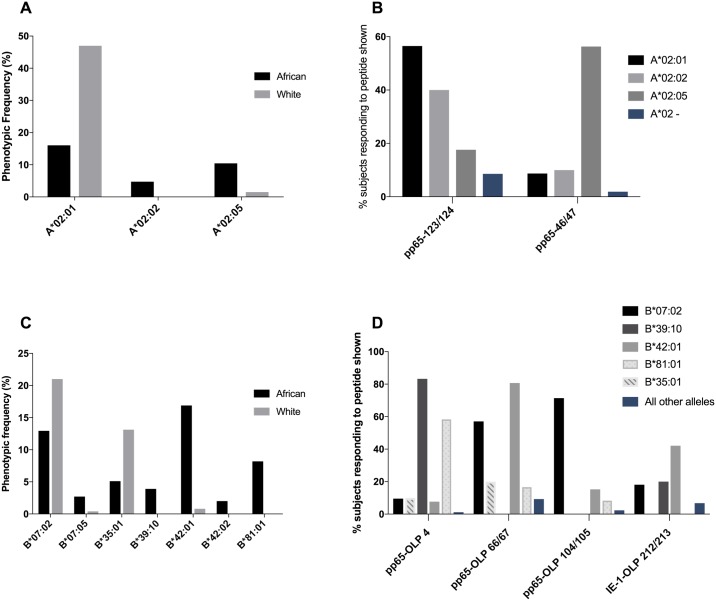
Phenotypic frequencies of closely related HLA I molecules and their impact on CMV specific CD8+ T-cell hierarchies.(A) The phenotypic frequency of some of the HLA class I molecules in A2 superfamily in white populations [28] and our African cohort. (B) The percentage of subjects with HLA alleles A*02:01 (n = 23), A*02:02 (n = 10) and A*02:05 (n = 16), responding to epitope (NLVPMVATV) in pp65-123/124 peptide and predicted epitope (FVFPTKDV) in pp65-46/47 peptide. (C) The phenotypic frequency of the HLA class I molecules in B07 superfamily in white populations [28] and our African cohort. (D) The percentage of subjects with B*07:02 (n = 21), B*35:01 (n = 10), B*39:10 (n = 6), B*42:01 (n = 26) and B*81:01(n = 12) alleles in our African cohort responding to predicted epitopes in pp65, GPISGHVL (OLP-4), RPHERNGFTVL (OLP-66/67) and TPRVTGGGAM (OLP-104/105). The percentage of subjects in our African cohort responding to predicted epitope in IE-1, TMYGGISLL (OLP-212/213) with HLA-B*07:02 (n = 11), B*35:01 (n = 6) B*39:10 (n = 5), B*42:01 (n = 19) and B*81:01(n = 1) alleles.